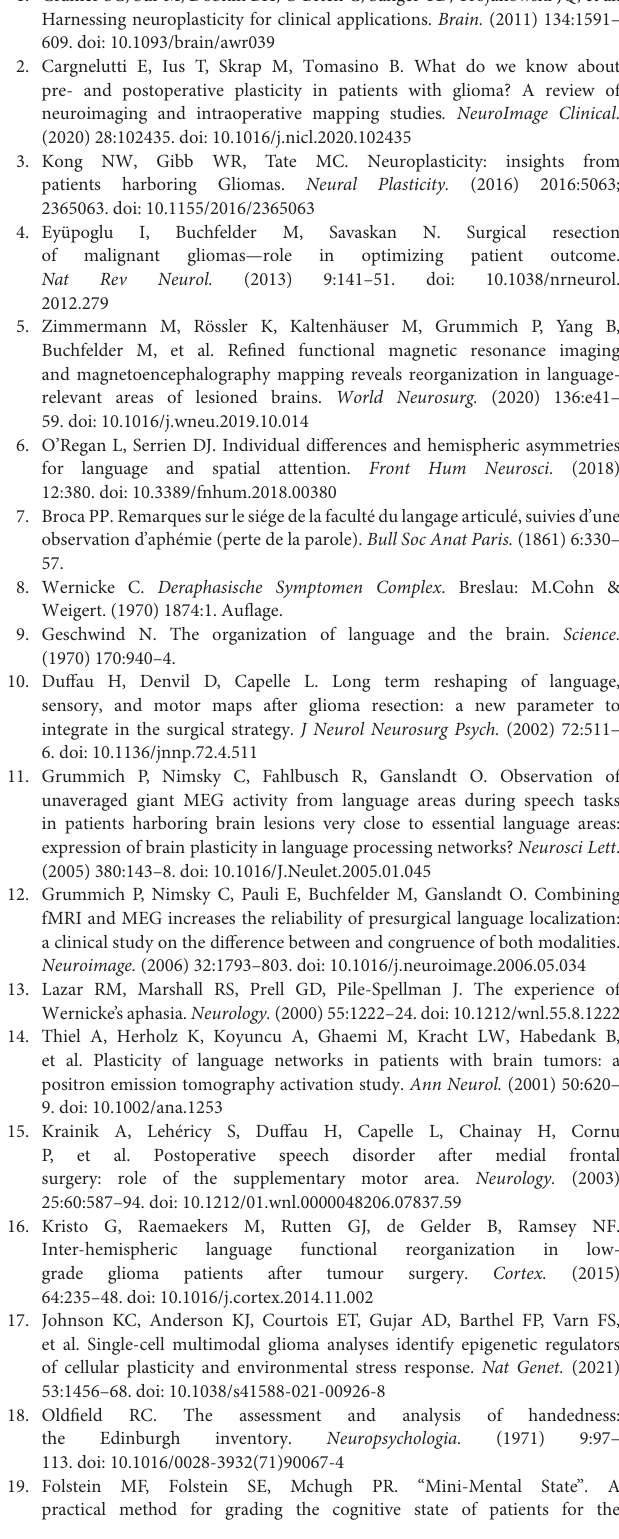
Figura di Rey. Nuova Rivista di Neurologia. (2002) 12: 1–13. 28. CaffarraP,VezzadiniG,DieciF,ZonatoF,VenneriA.Rey-Osterriethcomplex figure:normativevaluesinanItalianpopulationsample. Neurol.Sci .22(2002) 6:443–447. doi: